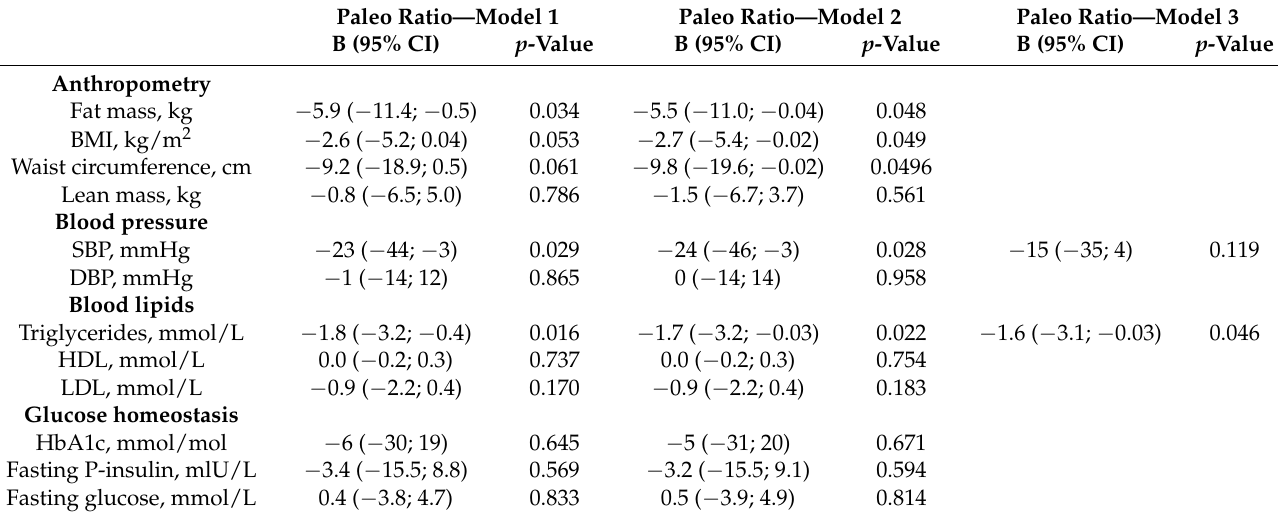
Table 4. Association between the Paleo ratio and outcome variables after 12 weeks of intervention. Paleo Ratio—Model 1 Paleo Ratio—Model 2 Paleo Ratio—Model